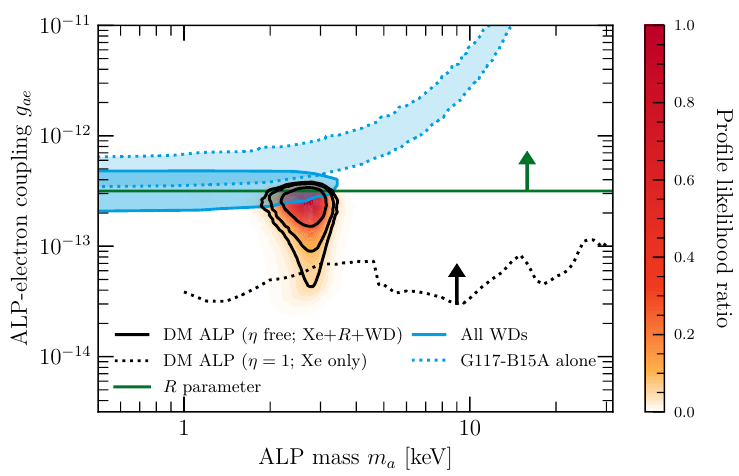
Figure 5. The profile likelihood (yellow-red density plot) and 68%/90%/95% CL regions (solid black; 2 DOF) for the DM ALP mass and DM ALP-electron coupling with Xe + R + WD data. For context, we show the 90% CL constraints from Xe assuming η = 1 (dotted black), the R pa- rameter (green), and the region hinted by a combination of WDs (shaded blue region, solid line). We also show one WD (G117-B15A) alone for comparison (shaded blue region, dotted line). The arrows point towards the excluded